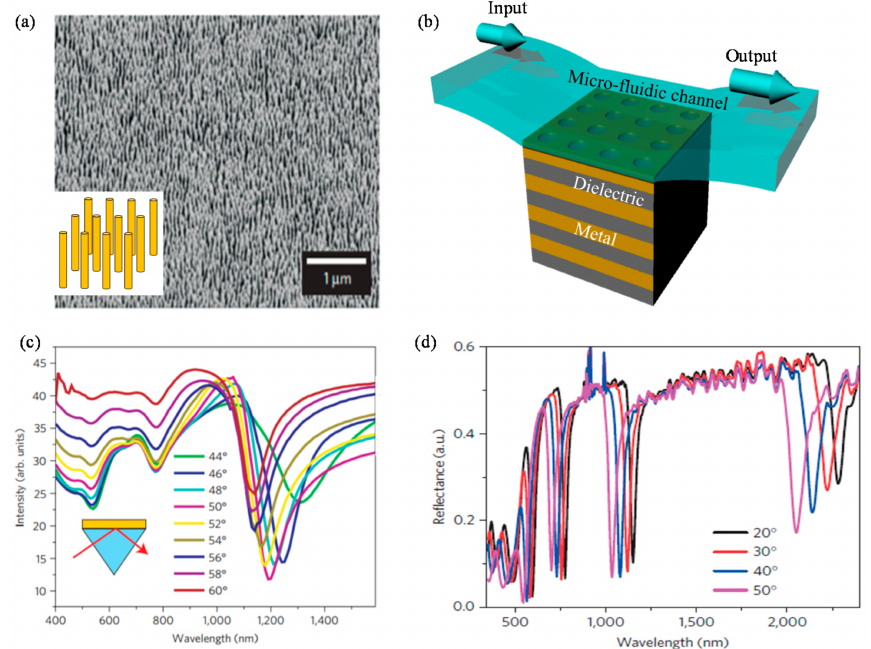
Figure 9. ( a ) Scanning electron microscopy image of standing gold nanorods assembly with subwavlength spacings made by A. V. Kabashin et al. [135]. The inset figure presents magnified scheme of standing gold nanorods; ( b ) Scheme of the grating coupled HMM consists of alternatively stratified metal nanolayers and dielectric nanolayers demonstrated by Sreekanth et al. [136]; ( c ) Attenuated total reflection (ATR) spectra for nine different incidence angles when nanorod HMM of ( a ) is located in water environment ( n = 1.33); ( d ) ATR spectra of the grating coupled HMM depicted in ( b ) for four different incidence angles. The legends in ( c , d ) denote the incidence angles. Reprinted by permission from Macmillan Publishers Ltd.: (Nature Materials) (Reference [135]), copyright (2009) and (Nature Materials) (Reference [136]), copyright